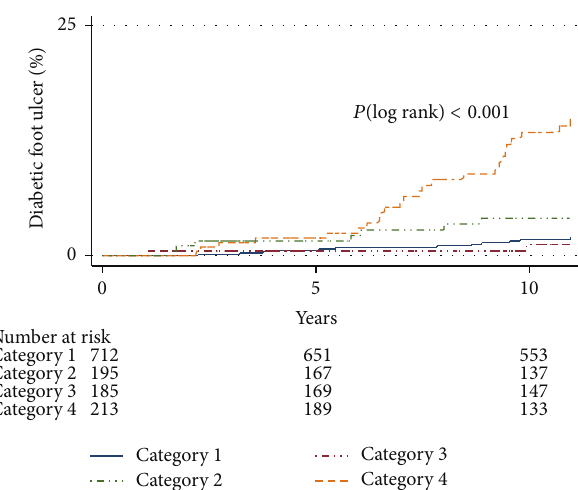
Figure 1: Unadjusted Kaplan-Meier estimates of the occurrence of diabetic foot ulcers over 10 years. The data shown are for patients with different microangiopathy complications at